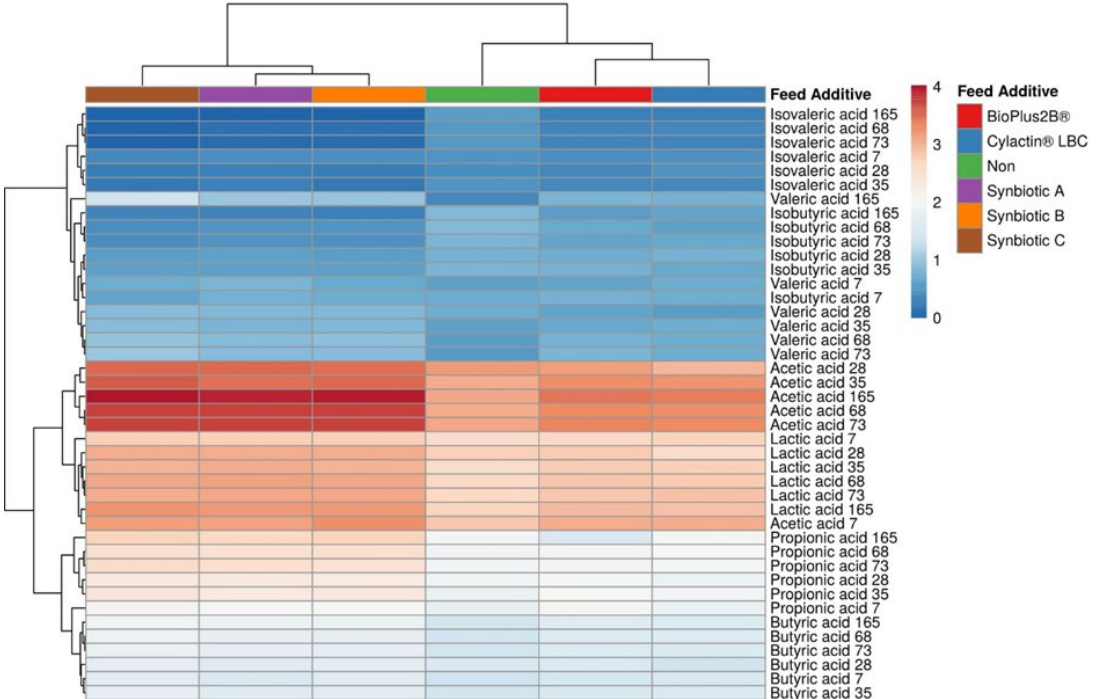
Figure 4. Heatmap presents changes in lactic acid, SCFAs, and BCFAs concentrations in piglets’ feces in correlation with the administrated feed additives. Columns correspond to the preparations used to modify piglets feed (directly or indirectly), whereas rows are assigned to analyzed organic acid and the day of piglets’ life when fecal samples were collected, namely, 7th and 28th (suckling piglets), 35th and 68th (weaned piglets), and 73rd and 165th (finisher pigs).